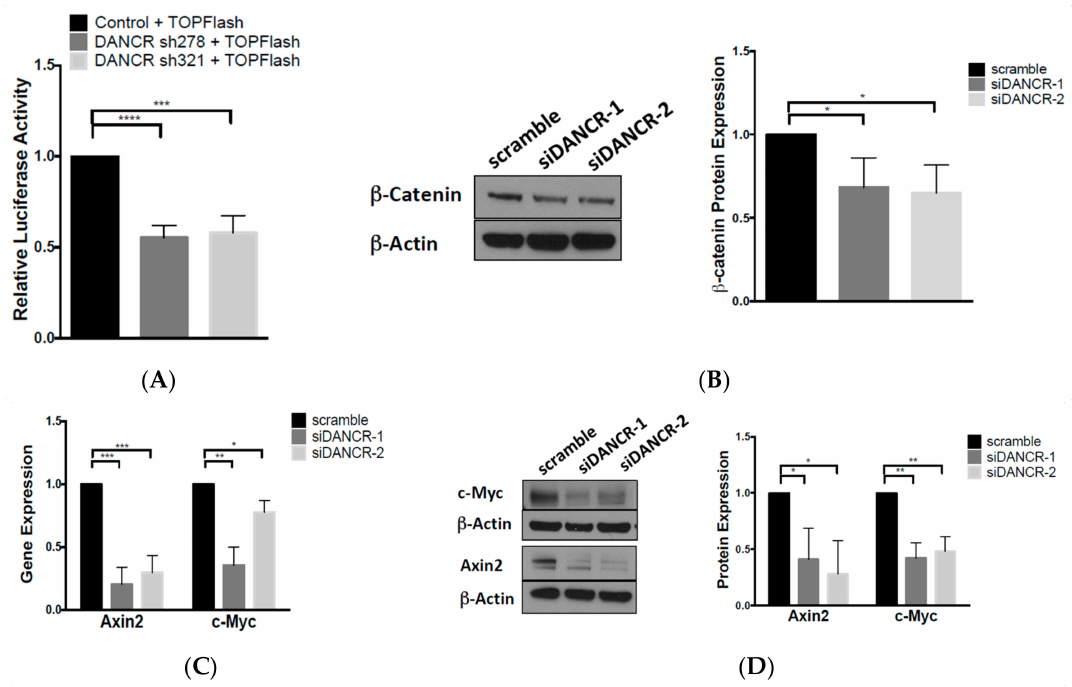
Figure 4. LncRNA-DANCR regulates Wnt / β -catenin signaling. ( A ) β -Catenin activity in A549 cells cotransfected with TOPFlash luciferase reporter + DANCR shRNAs compared to cells transfected with TOPFlash luciferase reporter + scramble control ( n = 3, t test, *** p < 0.001, **** p < 0.0001); ( B ) fold change of β -catenin protein expression in A549 DANCR KD cells compared to scramble control ( n = 3, t test, * p < 0.05); ( C ) fold change of CMYC and AXIN2 gene expression in A549 DANCR KD cells compared to scramble control ( n = 3, t test, * p < 0.05, ** p < 0.01, *** p < 0.001); ( D ) fold change of c-myc and Axin2 protein expression in A549 DANCR KD cells compared to scramble control ( n = 3, t test, * p < 0.05, ** p <